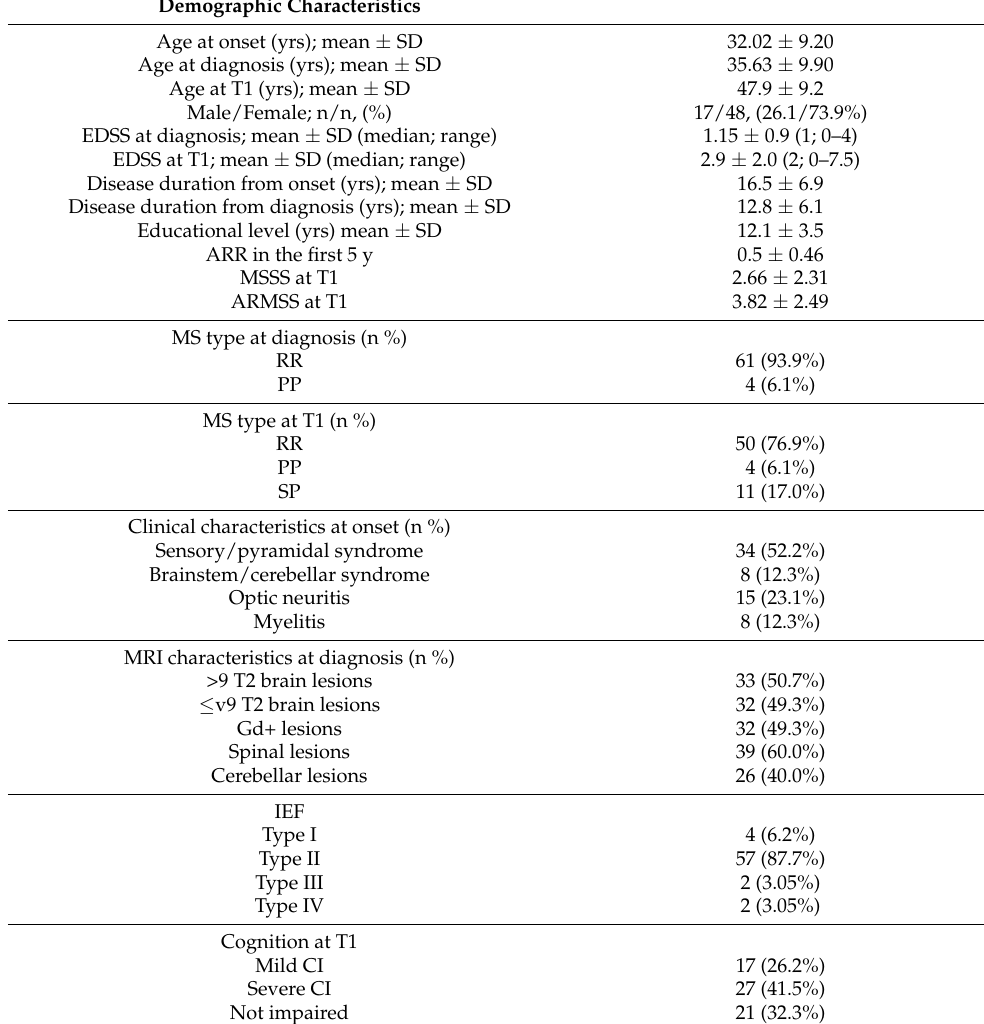
Table 1. The study population’s demographic, clinical, CSF, and MRI characteristics (N: 65). Demographic